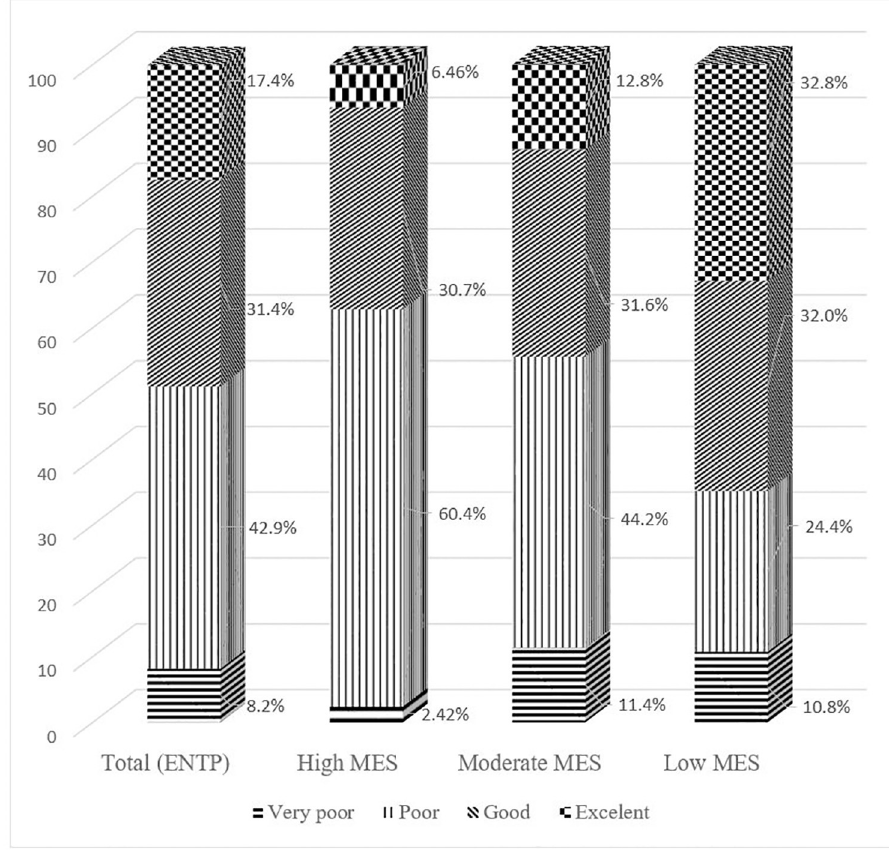
Fig 2. Distribution of malaria knowledge scores amongst